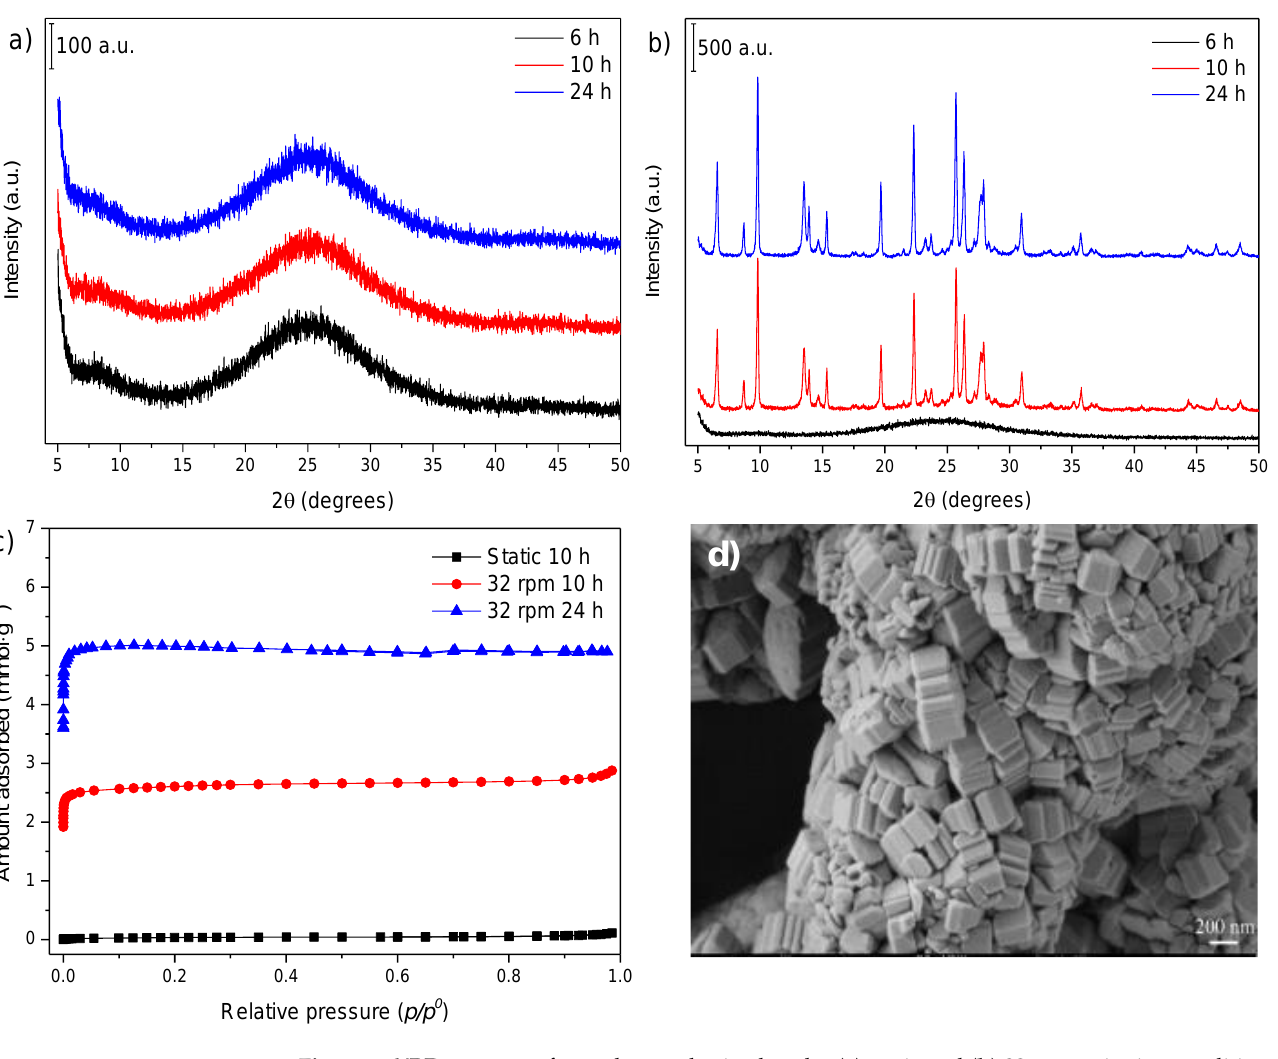
Figure 1. XRD patterns of samples synthesized under ( a ) static and ( b ) 32 rpm agitation conditions; ( c ) N 2 adsorption–desorption isotherms, and ( d ) SEM image of the sample obtained after 24 h at 32 rpm.